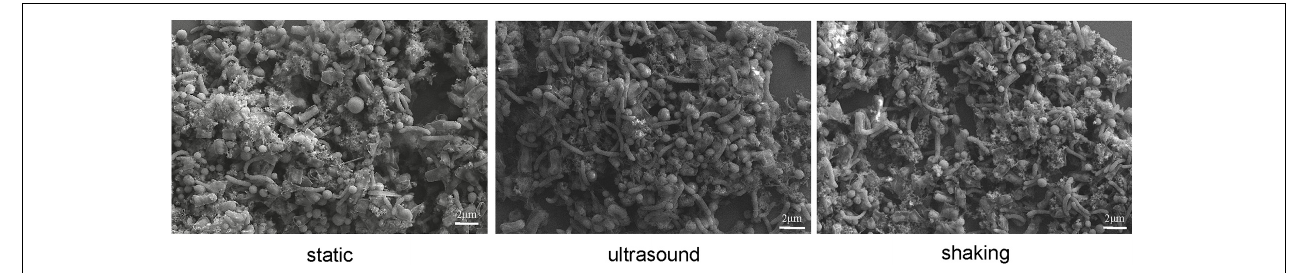
FIGURE 6 | Scanning electron micrographs of cell aggregates in Syntrophomonas – Methanococcus coculture at the end of incubation. Intermittent ultrasound and constant shaking were applied as the physical disturbance treatments with the static condition as the